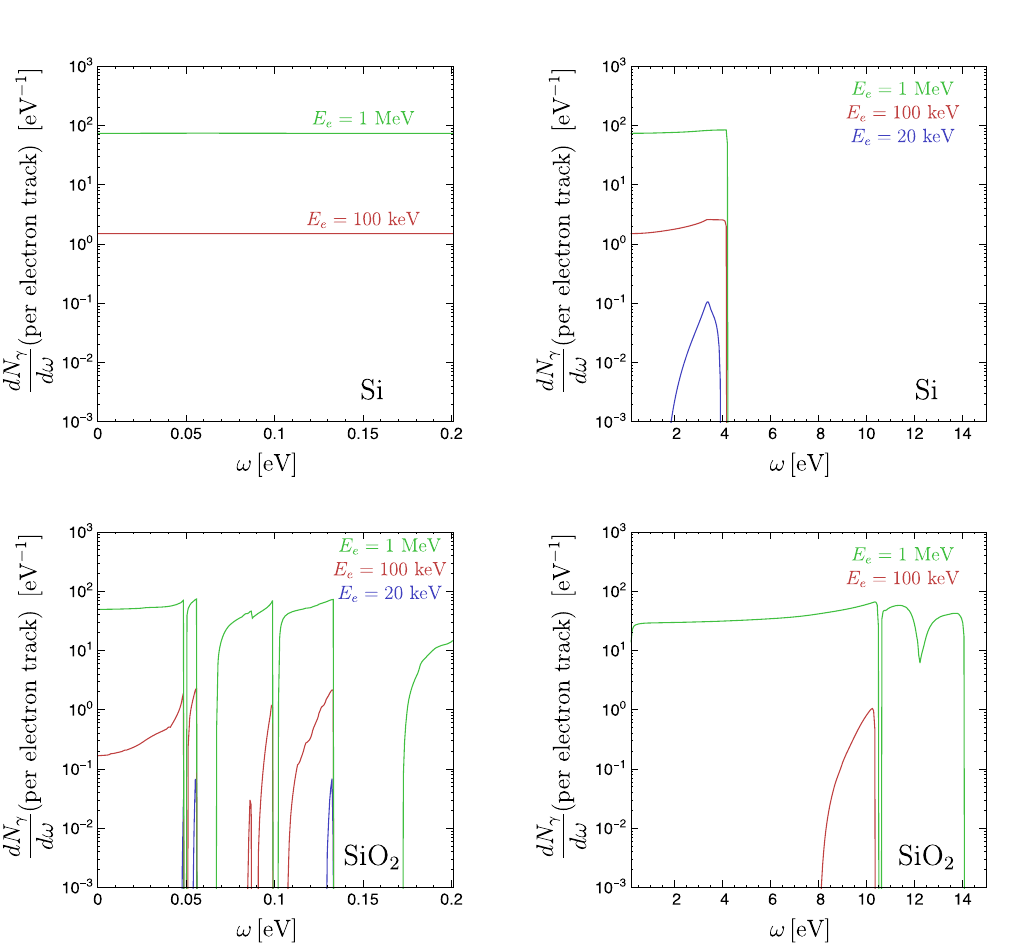
FIG. 5. Cherenkov radiation spectrum Eq. (2.6) of a single-electron track in Si (top) and SiO 2 (bottom). We show the emission ¼ 20 keV (blue line), E ¼ 100 keV (red line), and E ¼ 1 MeV (green line). For Si, spectrum for three different electron energies: E e e e there is no emission above approximately 4 eV, since Si becomes highly absorptive. The abrupt changes in the spectra for SiO 2 at low energies correspond to peaks in its dielectric function due to a strong optical phonon